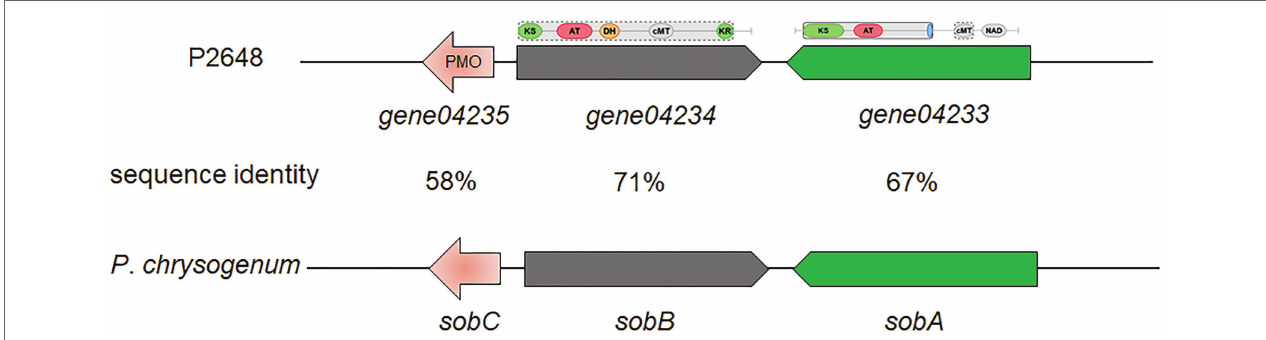
FIGURE 2 | The putative sorbocillin biosynthetic gene cluster of P2648 and the comparison of this cluster with the sorbocillin cluster reported for P. chrysogenum . PMO, monooxygenase; KS, ketosynthase domain; AT, acyltransferase; DH, dehydratase domain; cMT, carbon methyltransferase; KR, ketoreductase domain; and NAD, male sterility protein.